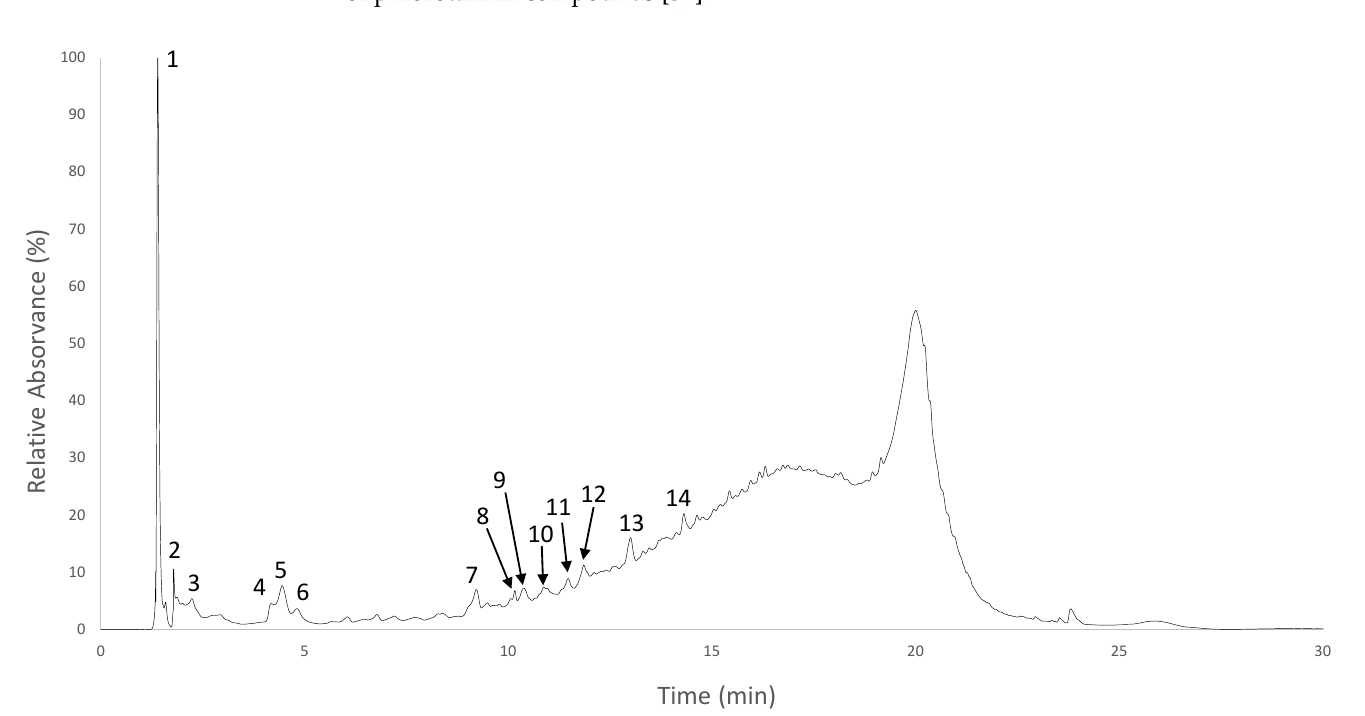
Figure 1. Chromatographic profile of the ethyl acetate fraction of H. elongata extract at 280 nm. Peaks marked with numbers correspond to the tentatively assigned compounds listed in Table 2.